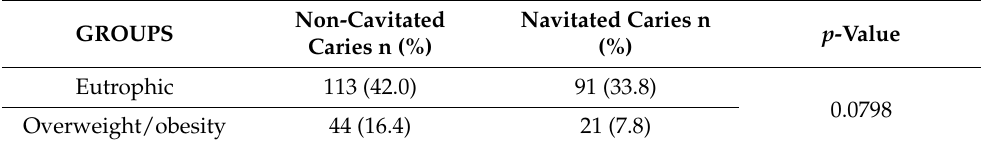
Table 2. Overweight/obesity distribution according to